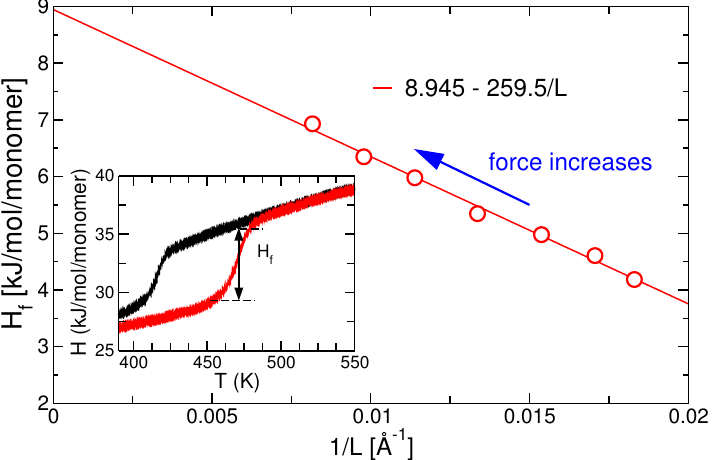
Figure 7. Enthalpy of fusion as a function of the inverse stem length. Different data points corre- spond to different forces. The inset displays the enthalpy as a function of temperature during a cooling/heating cycle for zero